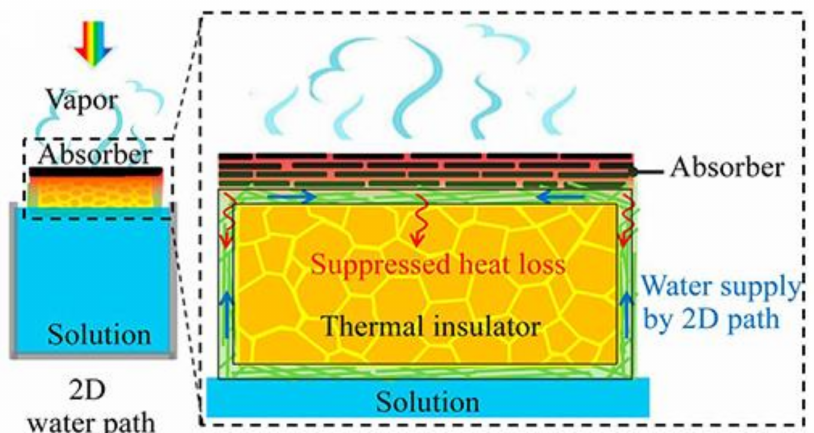
Figure 8. Schematic diagram of solar desalination device for 2D water supply [7]. Reproduced with permission. Copyright 2016, National Academy of